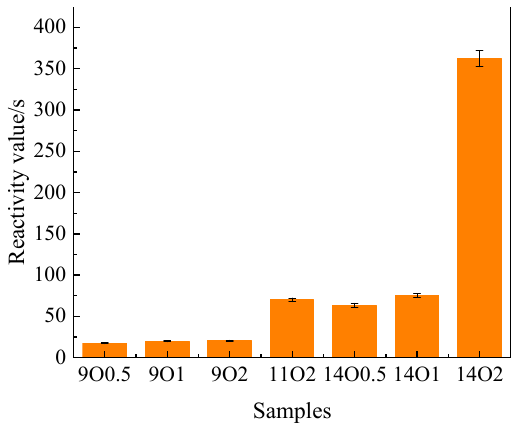
Figure 4. Reactivity values of MgO calcined at different temperatures and times, cooled in the oven.